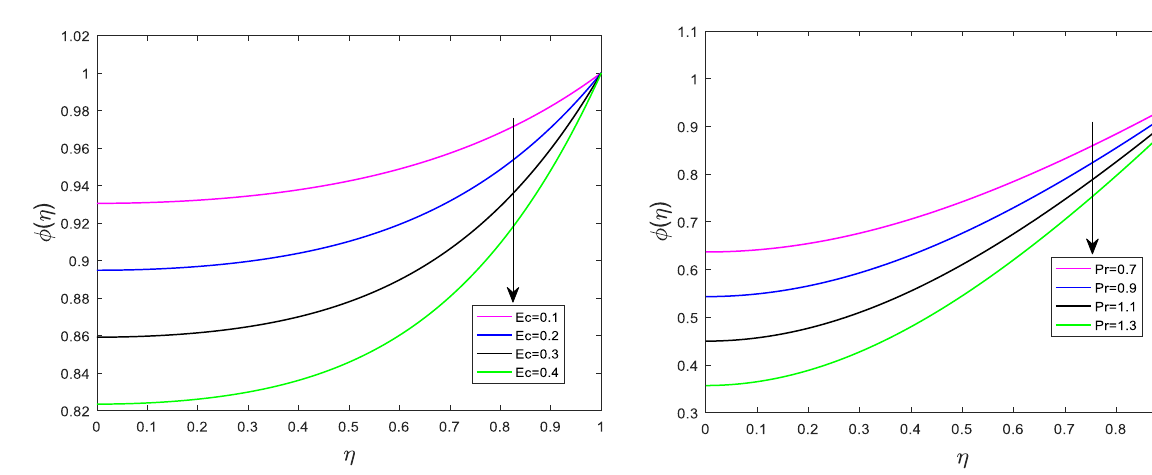
= β = Ω = 0.5, Pr = 0.7, and Sc = 0.7 T b